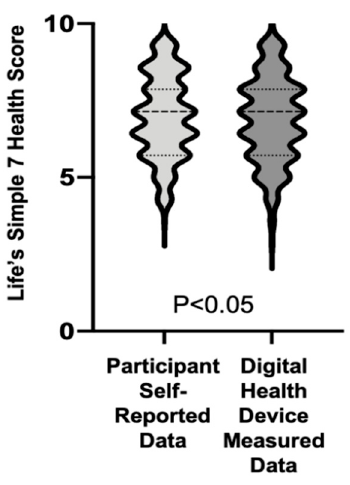
Figure 4. Life’s Simple 7 Health Score based on digital health device data. Life’s Simple 7 Health Score calculated with digital-health-device-measured body mass index and exercise data was compared to the Life’s Simple 7 Health Score calculated with participant self-reported data. Results are summarized graphically in violin plots. Median and quartiles are denoted by dashed lines ( n = 272).